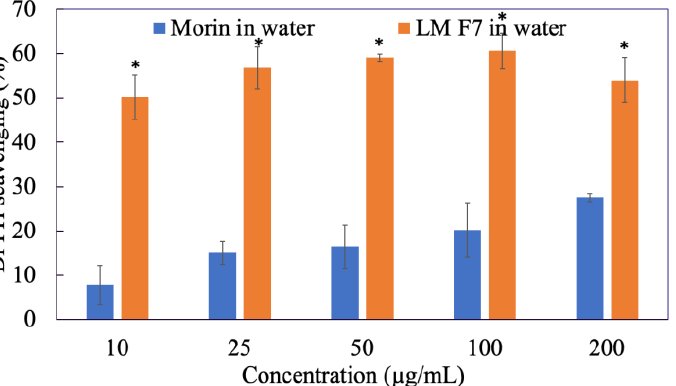
Figure 9. DPPH • radical scavenging activity of morin in water compared to liposomal morin formulation 7 (LMF7). Data were presented as mean ± SD and from triplicate experiments. * indicates a statistically significant difference between morin and LMF7 in water, p < 0.05.